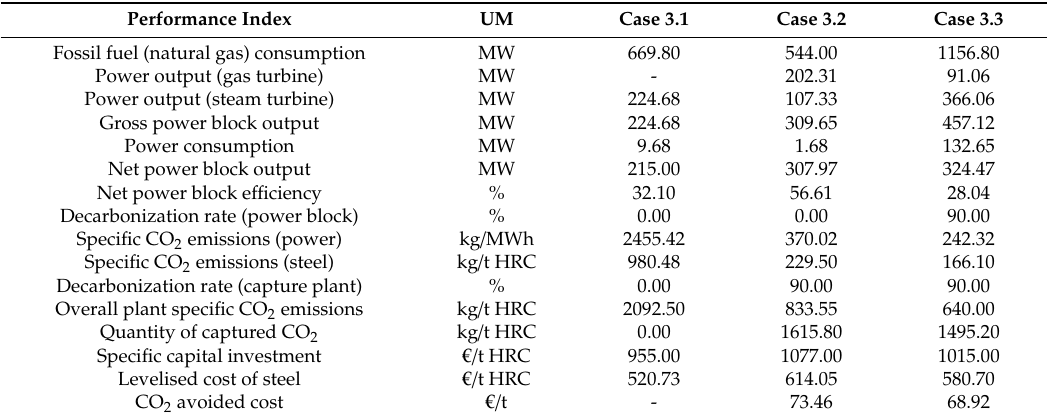
Table 5. Integrated steel mills techno-economic and environmental performance